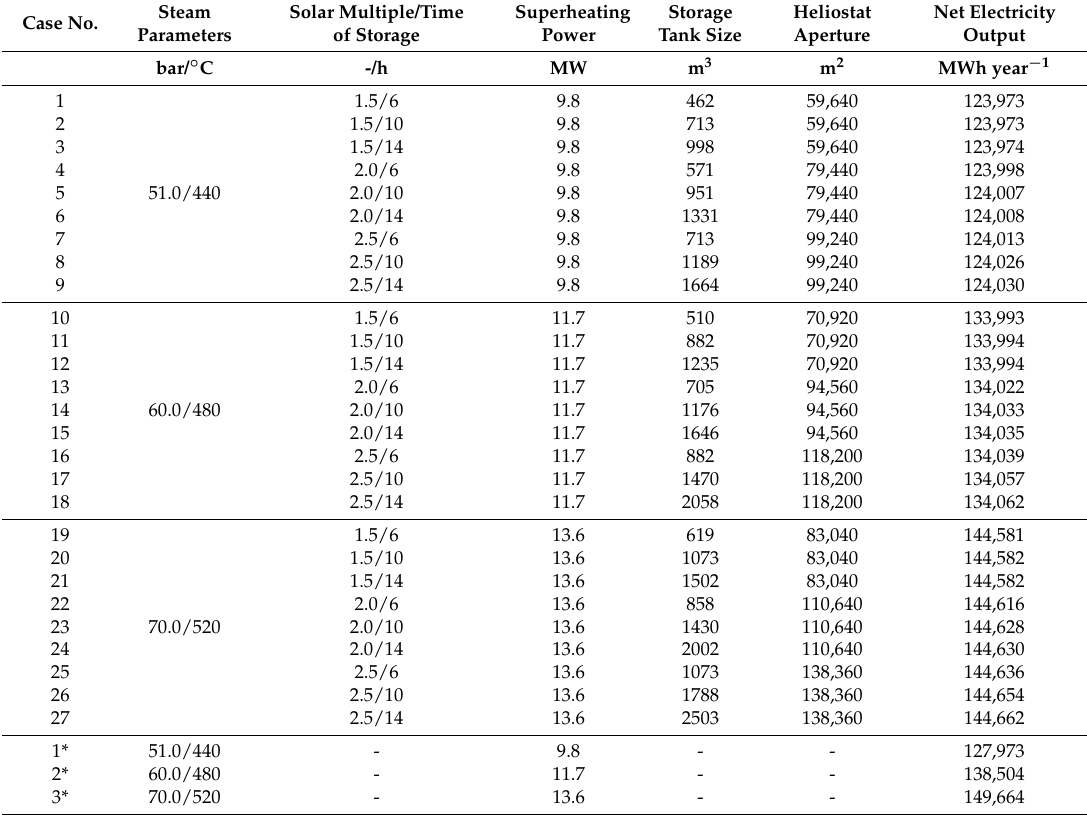
Table 1. Performance outputs and size parameters for analyzed WtE + CSP cases.